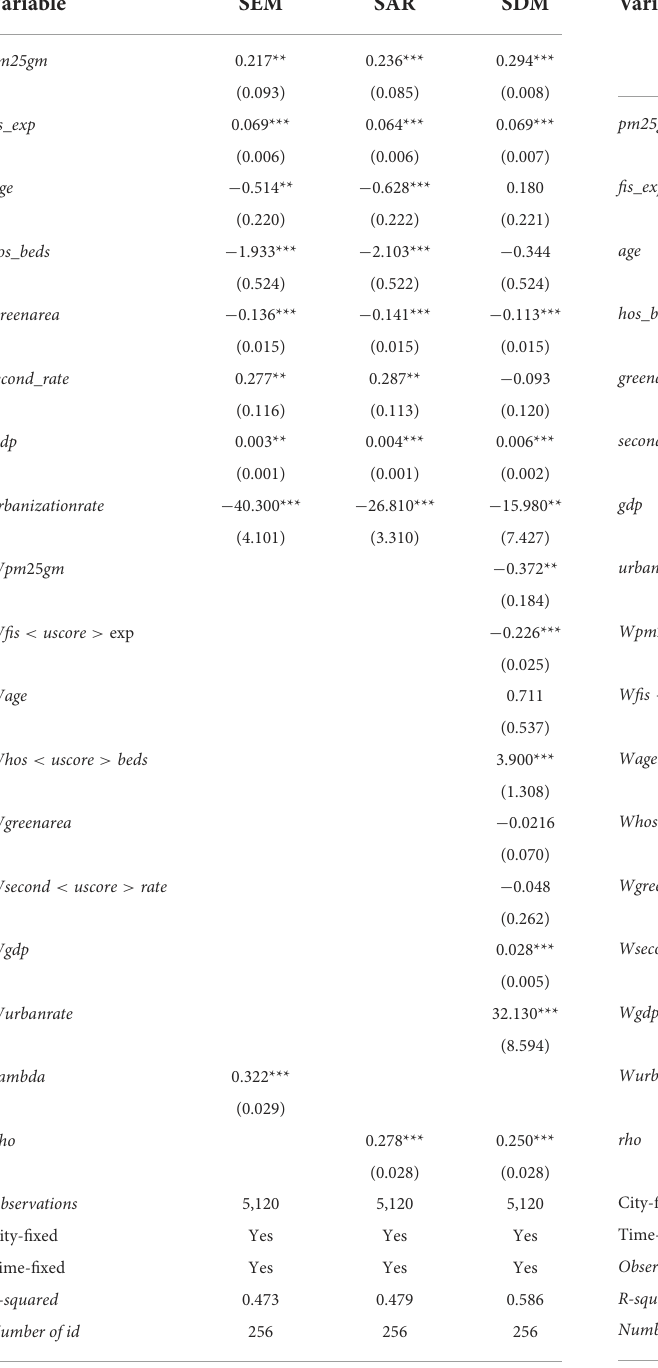
TABLE 9 Regression results of the spatial Durbin model. TABLE 10 Regression results of different spatial